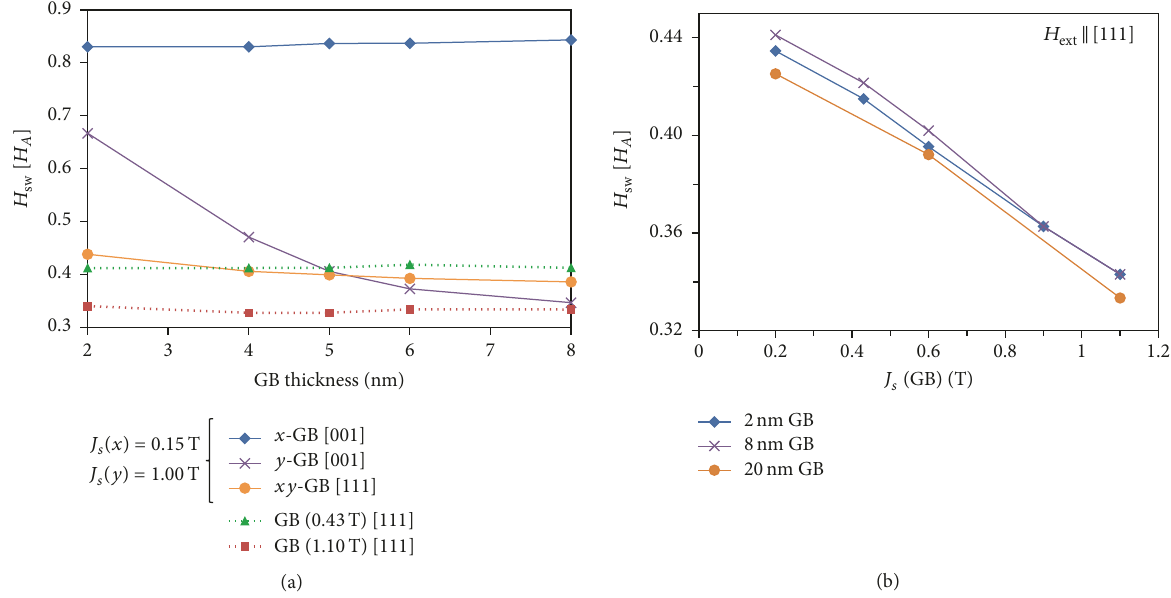
Figure 15: (a) Influence of the GB thickness on 𝐻 sw : for the three different 2-G model structures of Figure 14 (solid lines). In comparison the GB with averaged homogeneous magnetic properties of 𝐽 𝑠 = 0.43 T 𝐽 𝑠 = 1.10 T are shown (dotted line). (b) Influence of the averaged homogeneous saturation polarization of the GB-phase on 𝐻 sw in the 2-G model structure for different GB thickness, 𝐻 ext ‖ [111] . The 2-G model structure with a GB thickness of 20 nm has a size of 60 × 60 × 60